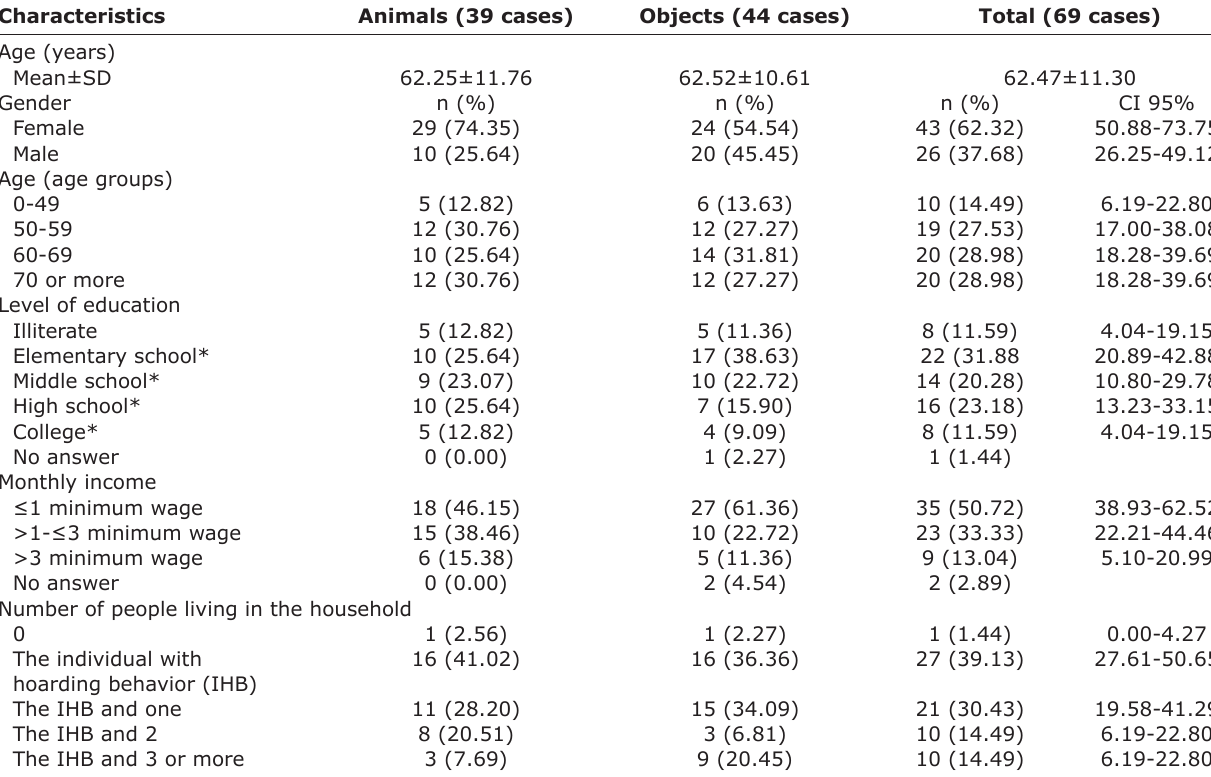
Table-1: Sociodemographic characteristics of hoarding behavior cases in Curitiba, Brazil, from 2013 to 2015.